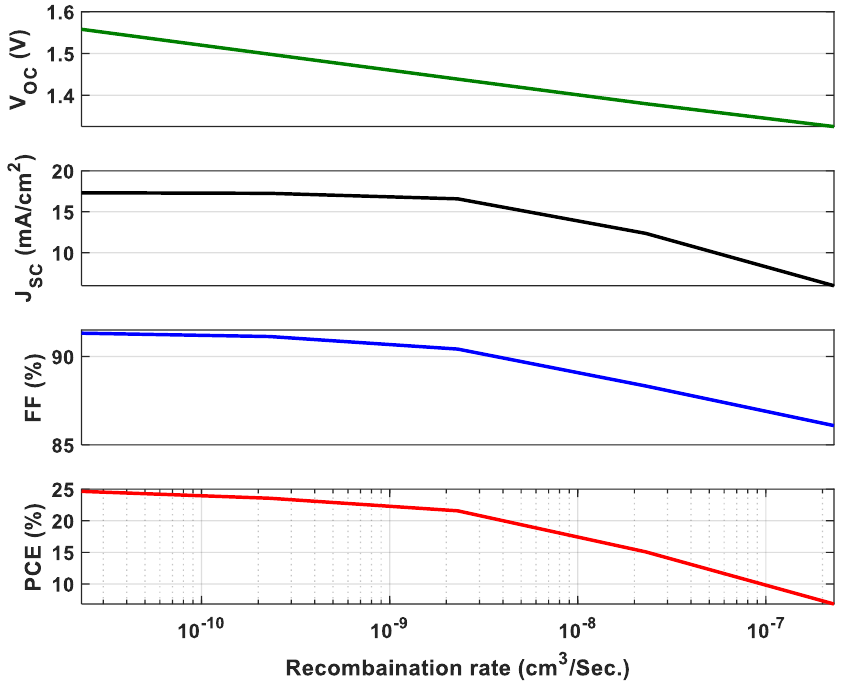
Figure 13. Effect of band-to-band radiative recombination rate on the performance parameters.